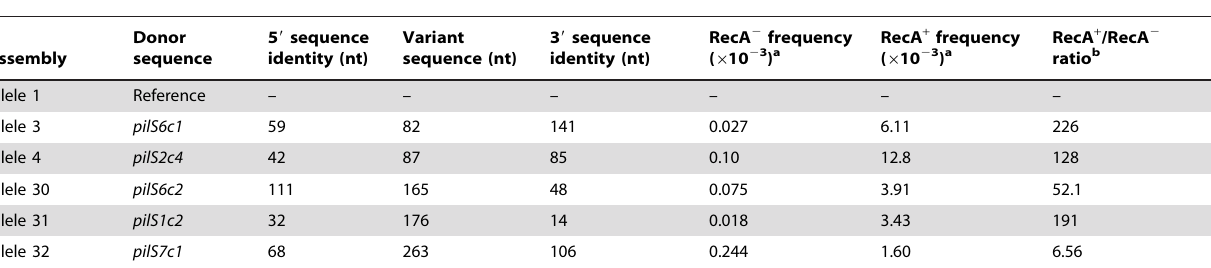
Table 4. Variant sequences detected in the repeat experiment with pilE from N. gonorrhoeae